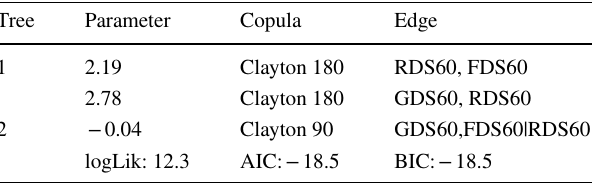
Table 5 Study results of C-vine copula for selecting copula function and type of tree in Tapik basin